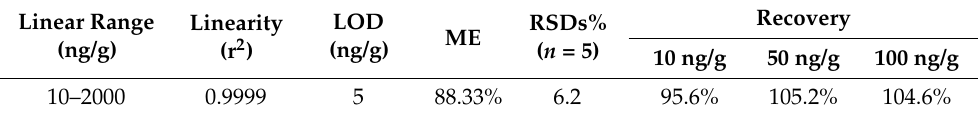
Table 1. Validation data of the developed method for the detection of fosetyl-Al.